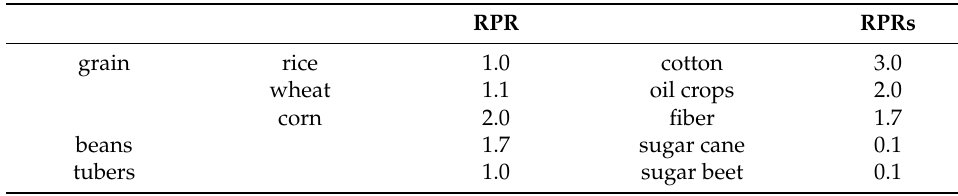
Table A1. Residue-to-product ratios (RPRs) of crops [32]. RPR RPRs grain